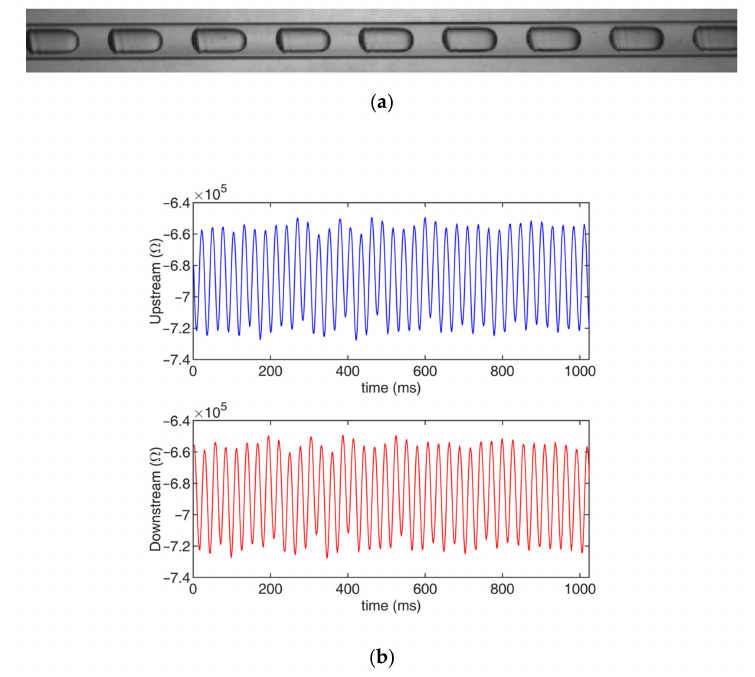
Figure 14. Typical slug flow with strong periodicity (experimental conditions: velocity, 0.41 m/s; time delay, 73.2 ms): ( a ) photo; ( b )